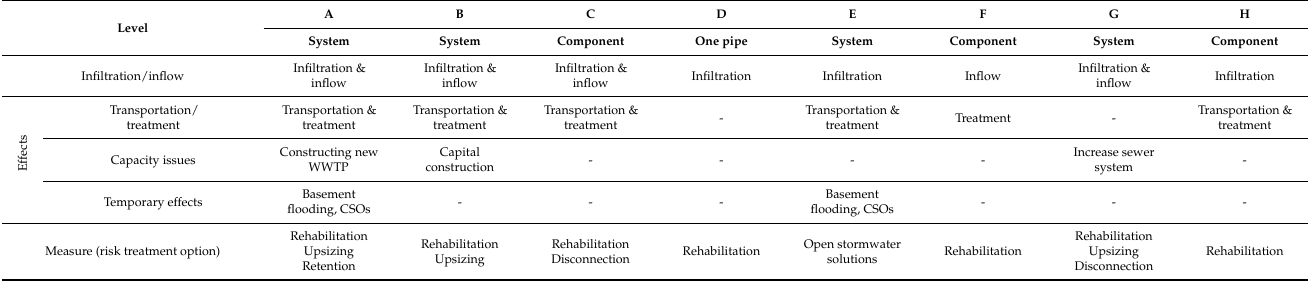
Table 3. Focus of evaluated models. A: Sola et al. [29], B: Davalos et al. [30], C: Diogo et al. [31], D: Moskwa et al. [32], E: Vallin [33], F: Lee et al. [34], G: King County [35], H: DeMonsabert and Thornton